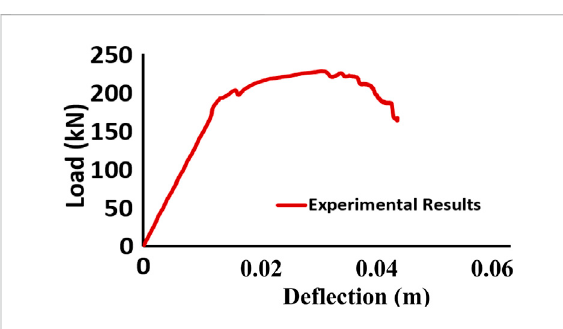
FIGURE 9 Crack and fl exure behaviour of RCB with 100% bottom